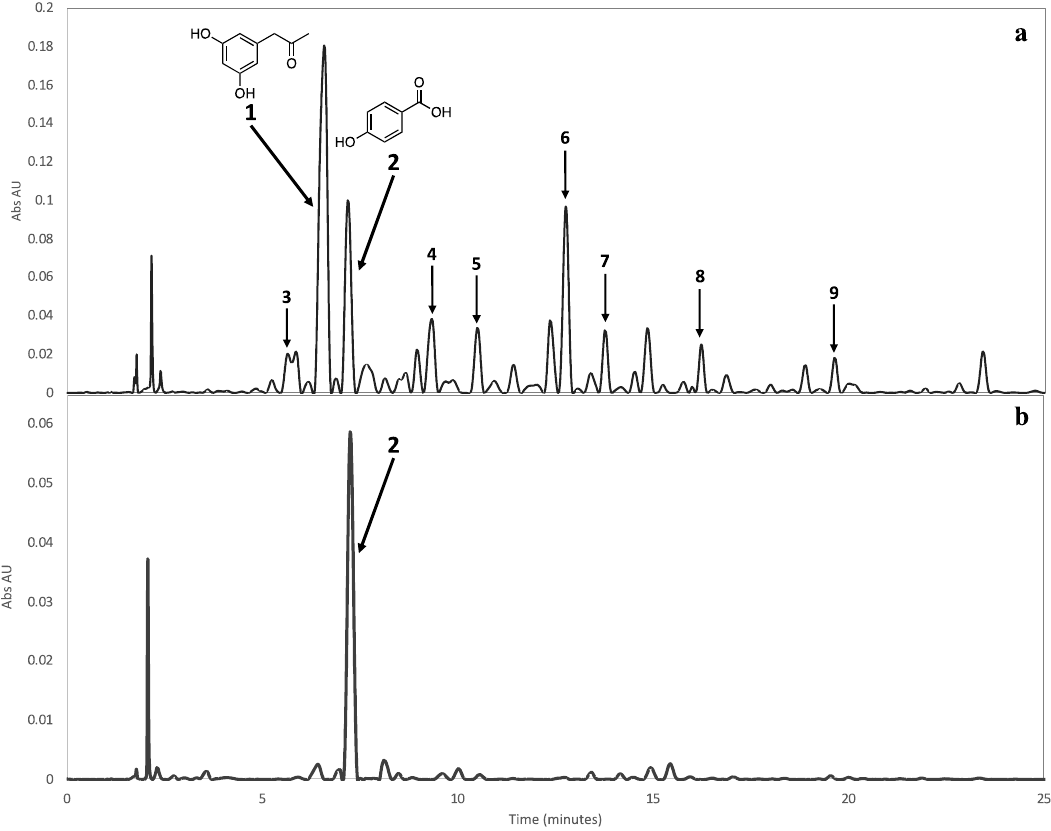
Figure 4. HPLC chromatographic profile of the medium polarity fraction from the extract of A. dauci at 96 h of culture. The chromatogram shows the peaks corresponding to α -acetylorcinol ( 1 ), p -hydroxybenzoic acid ( 2 ), and the diketopiperazines ( 3 – 9 ) at ( a ) 210 and ( b ) 257 nm.